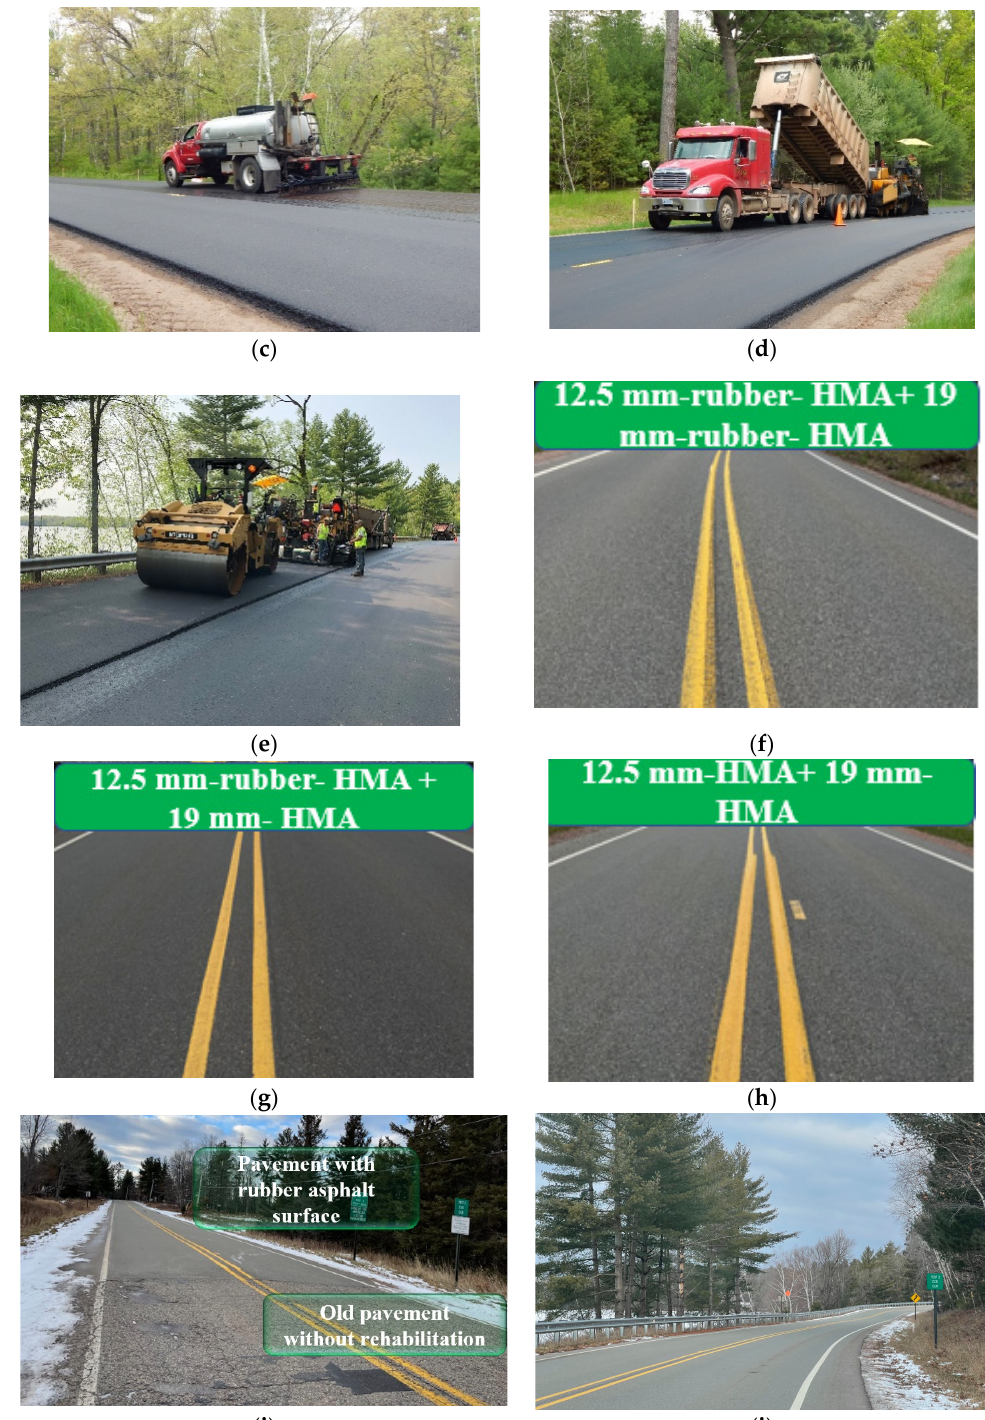
Figure 12. Field construction in Dickinson project. ( a ) Original pavement condition; ( b ) leveling layer compaction; ( c ) emulsion asphalt application for the leveling layer; ( d ) surface layer laydown; ( e ) surface layer paving and compaction; ( f ) rubber-modified asphalt pavement condition after construction (2 years); ( g ) rubber-modified overlay pavement condition after construction (2 years); ( h ) conventional pavement condition after construction (2 years); ( i ) old pavement without rehabilitation vs pavement with rubber asphalt surface (3 years); ( j ) rubber-modified overlay pavement after construction (3 years).